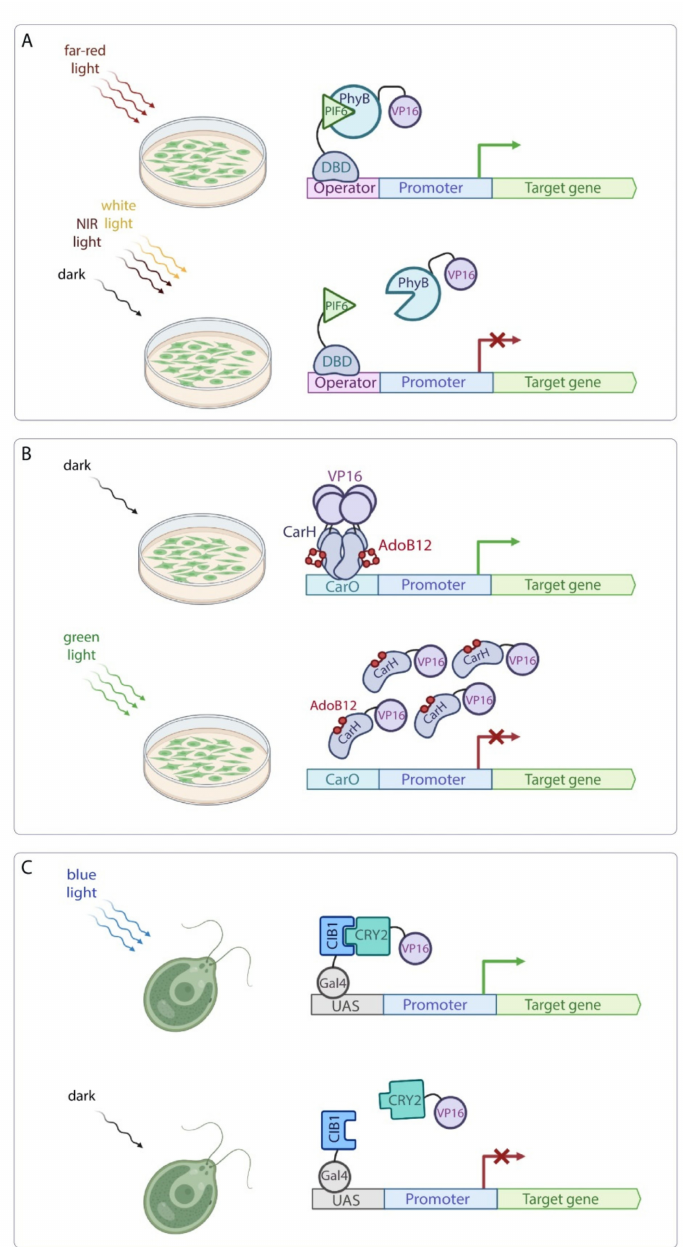
Figure 4. Application of optogenetic tools to control transgene expression in plants. ( A ) Applica- tion of the PhyB-PIF6 optogenetic pair in plant protoplasts. Far-red light (640–680 nm) induces heterodimerization of the PhyB and PIF6, resulting in activation of the reporter gene transcription. Incubation in darkness or illumination with NIR light (740–780 nm) inhibits this process. DBD – DNA-binding domain of the TetR, E or PiP proteins. ( B ) Green light-induced transcription inhibi- tion in plants. In darkness, bacterial photoreceptor CarH fused to the VP16 AD and linked to the chromophore AdoB12 binds to the CarO operator resulting in transcription activation of the target gene. Illumination with 525 nm light induces dissociation of the CarH tetramers releasing CarO and subsequent inhibition of the reporter gene expression. ( C ) Blue light-induced gene expression system in alga C. reinhardtii . Blue light (460–480 nm) stimulates CIB1 and CRY2 heterodimerization and thus brings the VP16 AD closer to Gal4 DBD that results in the activation of the target gene transcription. In darkness, CRY2-VP16 complex dissociates from CIB1-Gal4 DBD. UAS—upstream activation sequence; Gal4—Gal4